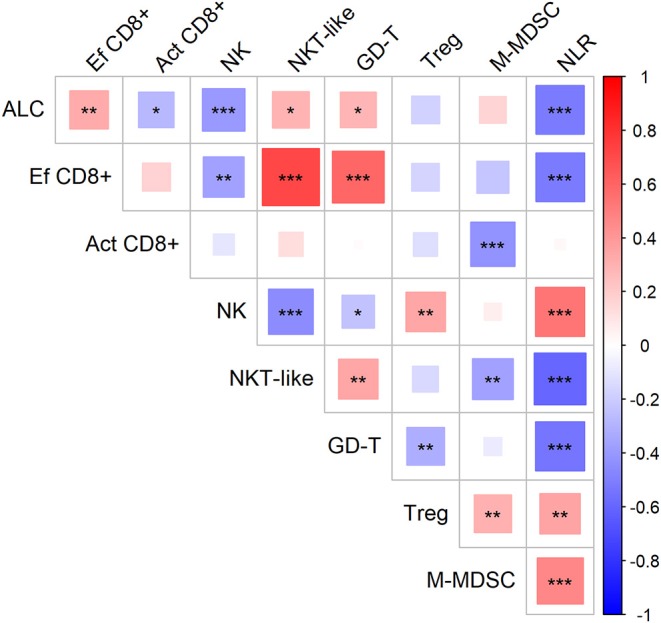
Association of circulating immune markers during the course (from baseline to the sixth dose) of therapy with dendritic cells (DCs) in sarcoma study group. Red—positive correlation, blue—negative correlation; strength of relationship is represented by size of the square and intensity of the color, larger squares with intensified color have stronger relationship; *p < 0.05, **p < 0.01, ***p < 0.001; ALC, absolute lymphocyte count (106/ml); NLR, neutrophil-to-lymphocyte ratio; Ef CD8+, circulating effector cytotoxic T-cells (% of CD27− of CD8+ T-cells); Act CD8+, activated cytotoxic T-cells (% of HLA-DR+ of CD8+ T-cells); NK, circulating NK-cells (% of lymphocytes); NKT-like, circulating NKT-like cells (% of lymphocytes); GD-T, γδ T-cells (% of lymphocytes); Treg, regulatory T-cells (% of CD4+ T-cells); M-MDSC, monocytic myeloid-derived supressor cells (106/ml).